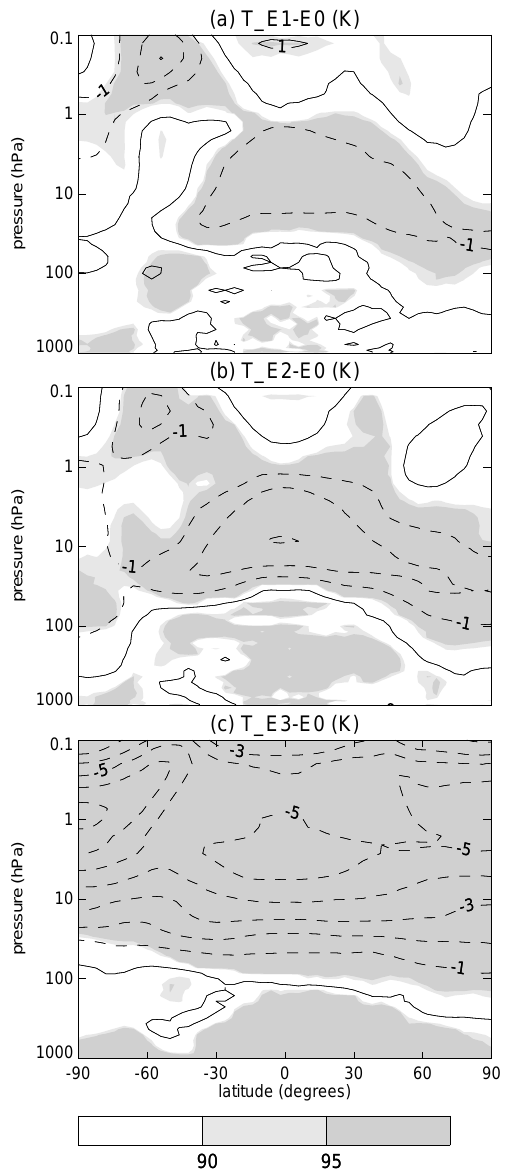
Figure 5. Latitude–pressure cross sections of differences in zonal mean temperature (2041–2050) between WACCM experiments (a) E1 and E0, (b) E2 and E0, and (c) E3 and E0. The contour interval is 1K. Grey colours represent statistical significance lev- els for the mean state differences between different experiments by Student’s t